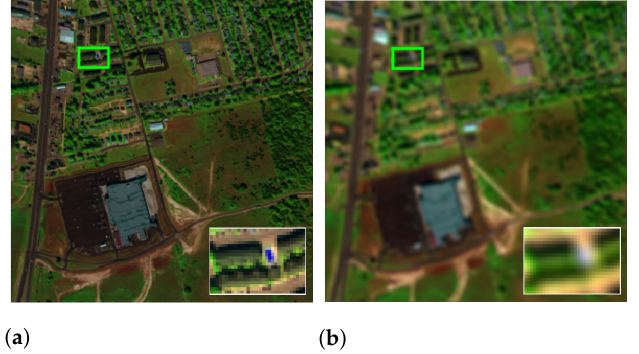
Figure 6. ( a ) Original three-color composite of three spectral bands (100, 55, and 30) from the Urban data set ( b ) degraded with Gaussian blur, with σ D = 2.3 and size 7 × 7. The portion of the image marked with a green rectangle is enlarged in the right corner.